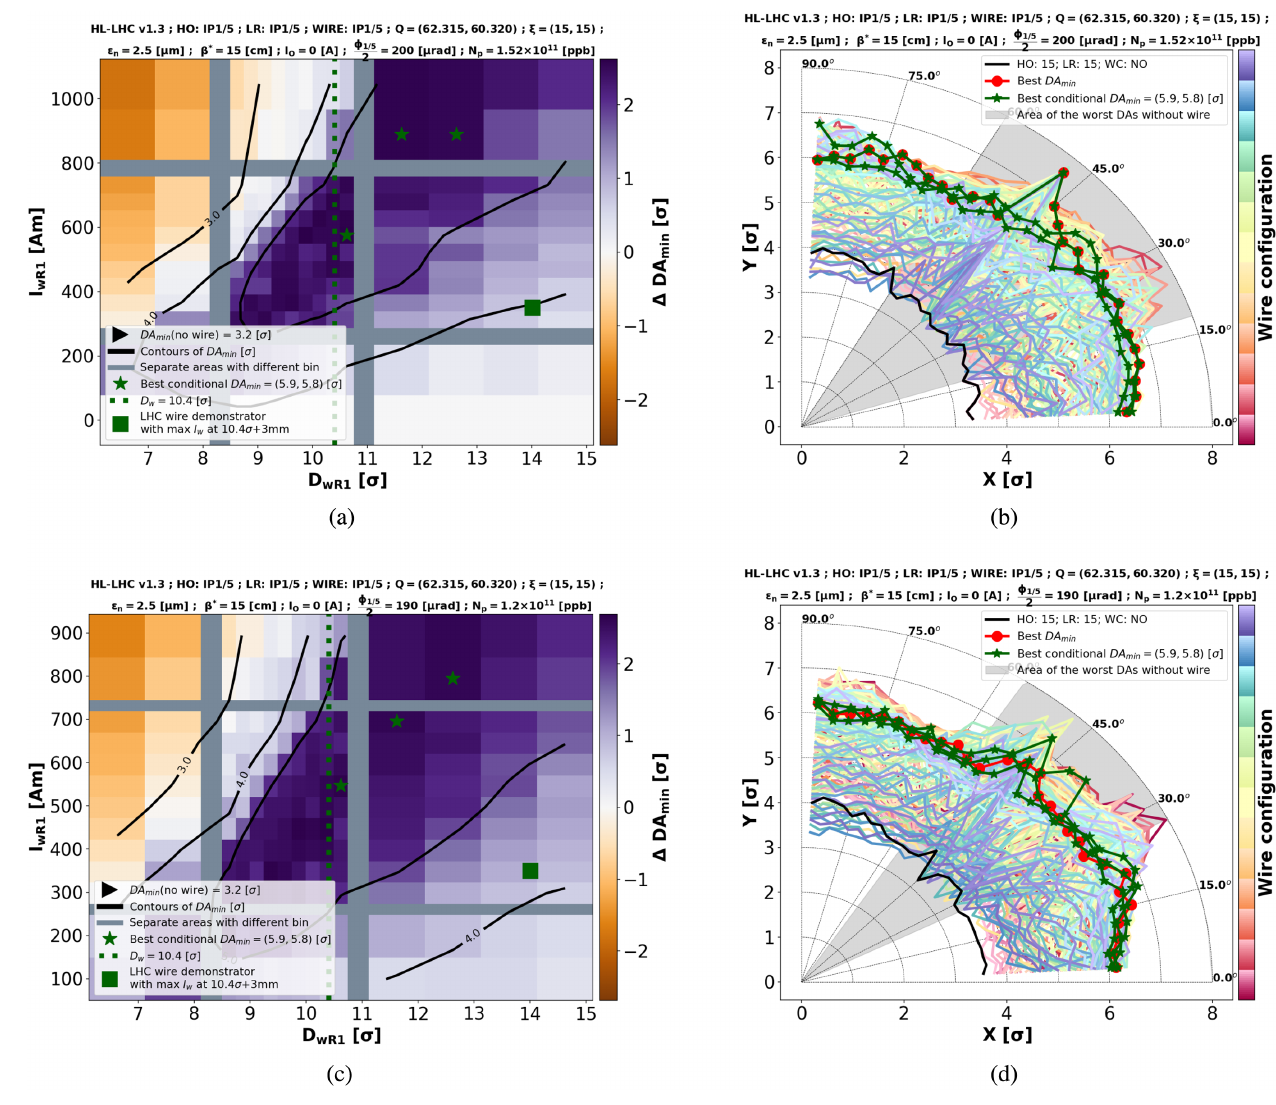
FIG. 6. HL-LHC at the end of luminosity leveling. (a) and (b) with half crossing angle at IP1 and IP5 200 μ rad and N p ¼ 1 . 52 × 10 11 ppb the Δ DA for different wire configurations and the DA values vs angles for the wire configurations that guaranty min ≥ DA DA (no wire), respectively. (c) and (d) with half crossing angle at IP1 and IP5 190 μ rad and N p ¼ 1 . 2 × 10 11 ppb the min min Δ DA for different wire configurations and the DA values vs angles for the wire configurations that guaranty DA min wire),